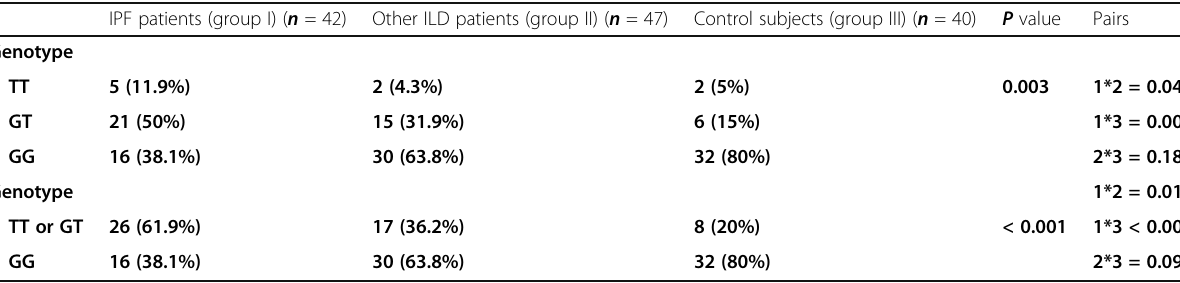
Table 2 The allele frequency of the genotypes of MUC5B promoter polymorphism among the 3 studied groups IPF patients (group I) ( n =